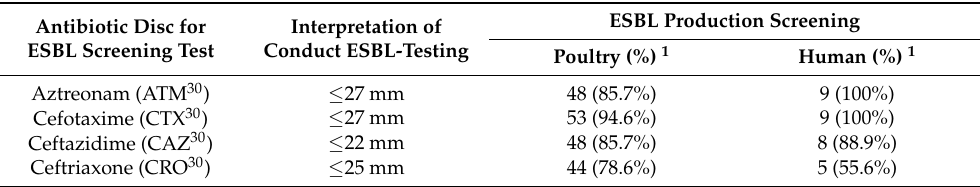
Table 3. ESBL screening test using the disc diffusion method for isolates obtained from poultry and